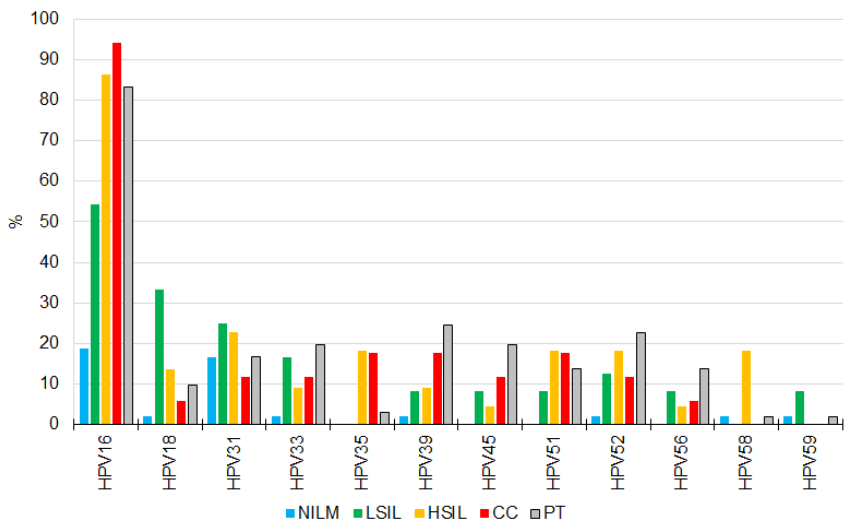
Figure 1. Prevalence (%) of 12 HR-HPV genotypes at different diagnoses and post-treatment. Red, cervical cancer; orange, HSIL; green, LSIL; blue, NILM; gray, the post-treatment (PT) group.